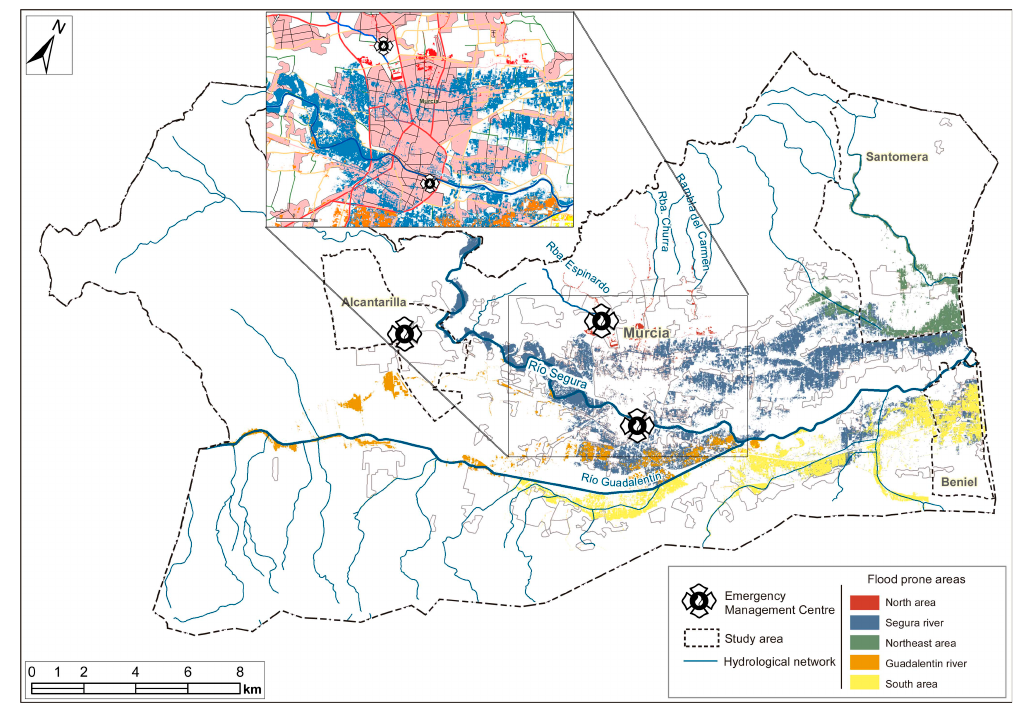
Figure 4. Flood-prone areas scenarios.